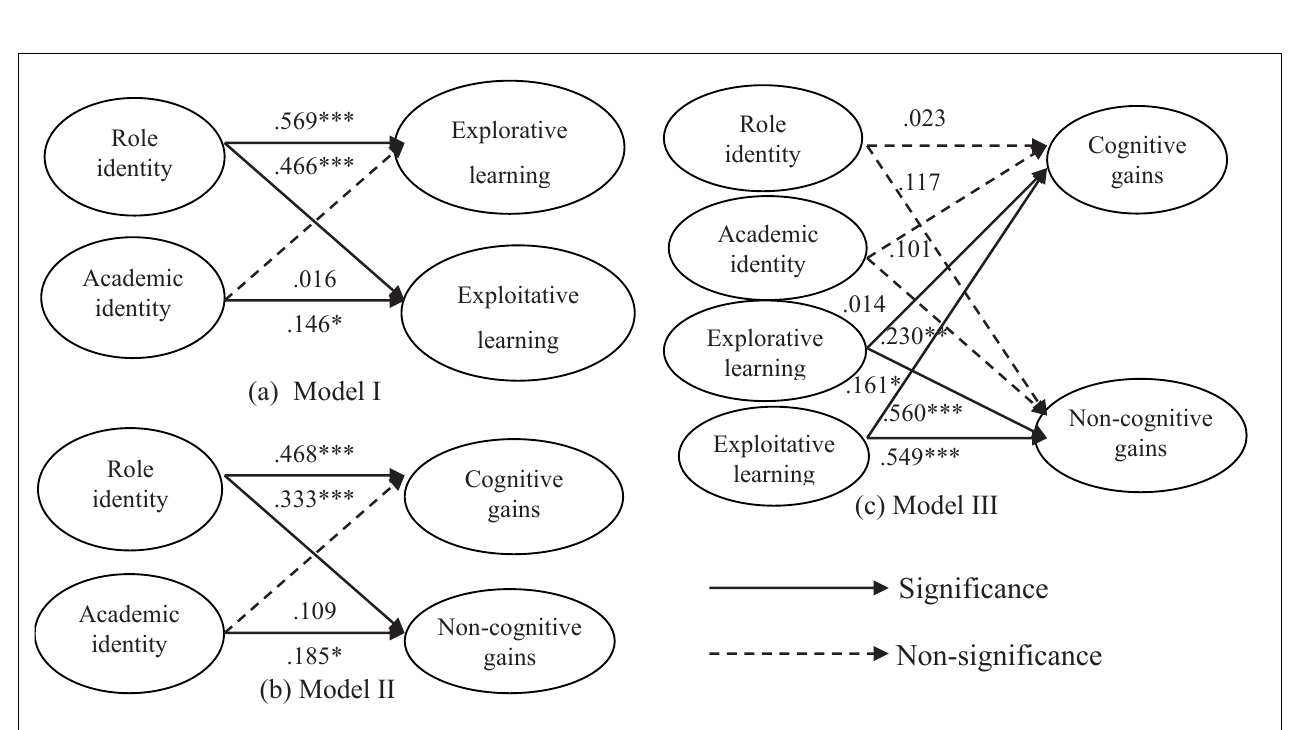
FIGURE 2 | Verification of mediating effects. * p < 0.05, ** p < 0.01, *** p <